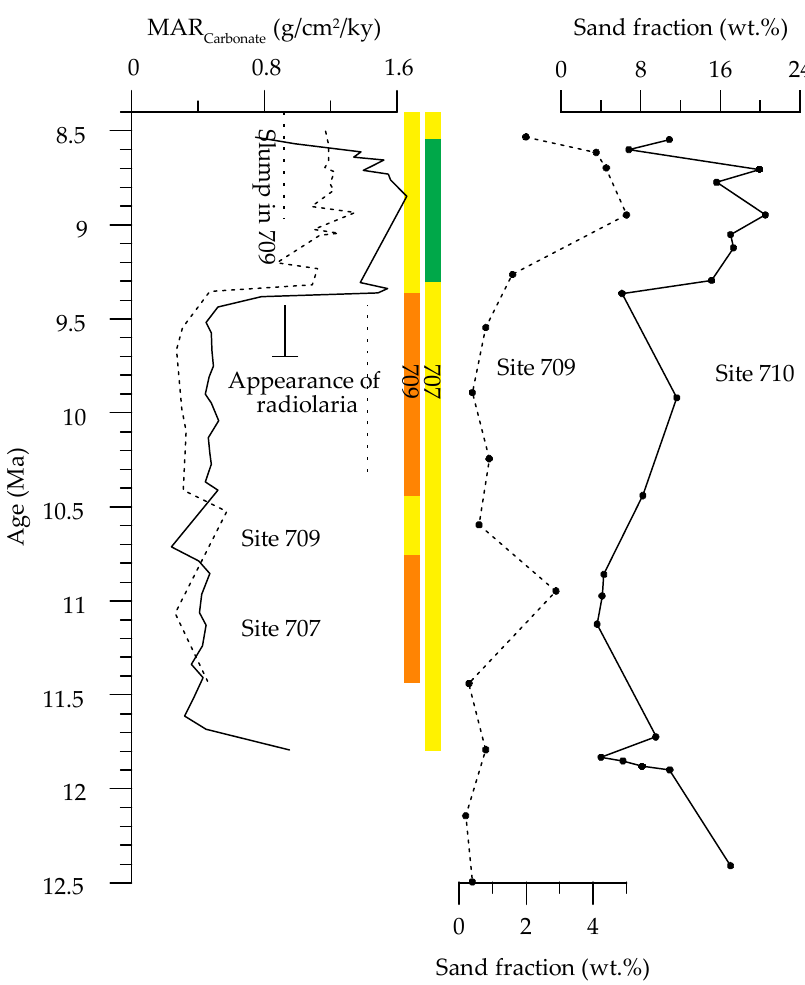
Figure 7. The Indian Ocean, represented by the Mascarene Plateau ODP sites 707, 709 and 710. The carbonate crash interval is characterized by very low carbonate MAR and low MAR gradients among different depths. The opal reappears in form of radiolaria at about 10 Ma. Coarse fraction contents point to better preservation after about 9.4 Ma. Colour bars refer to the preservation state of planktonic foraminifera as found in the ODP Initial Site Reports.